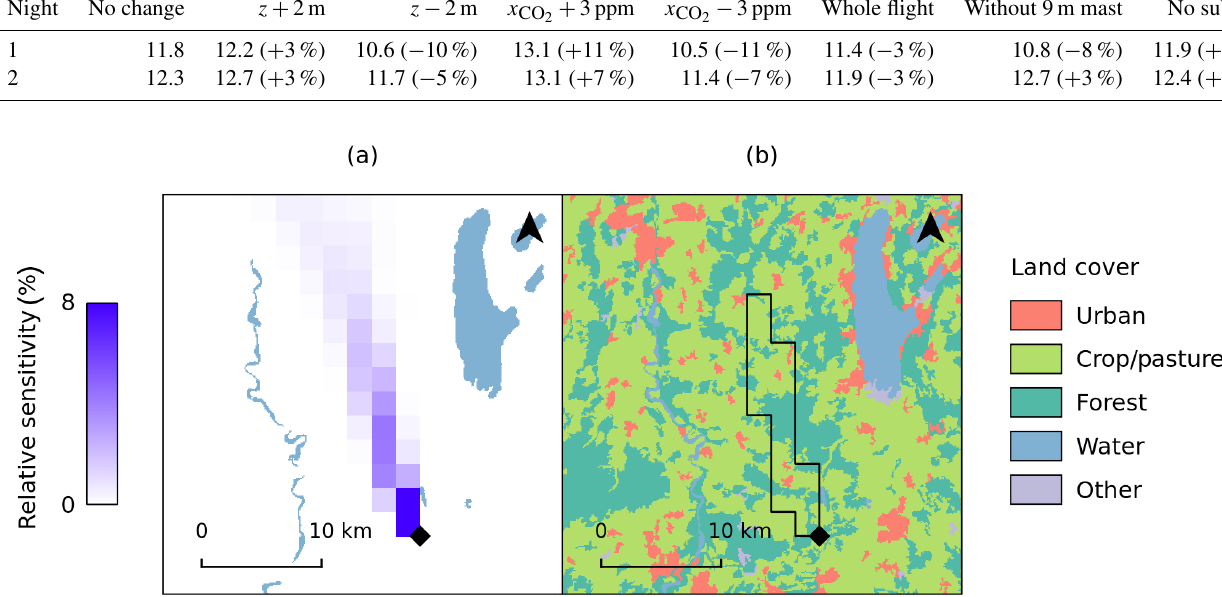
Figure 14. Footprint of an NBL budget at Fendt on 6 July, 21:00UTC. (a) Relative contribution of each grid cell to the total sensitivity of the budget to surface fluxes. Water bodies depicted for orientation. (b) Contour of all grid cells with a relative sensitivity of 1% or higher on top of a simplified land cover map (CORINE 2012 v18.5, European Environment Agency, EEA (2016)). The area observed is dominated by forests, pasture and